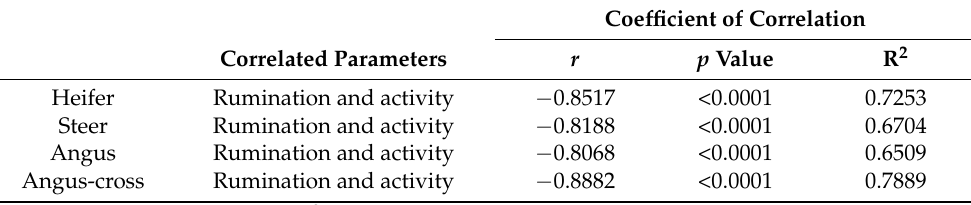
r = Pearson correlation coefficient, R 2 = coefficient of